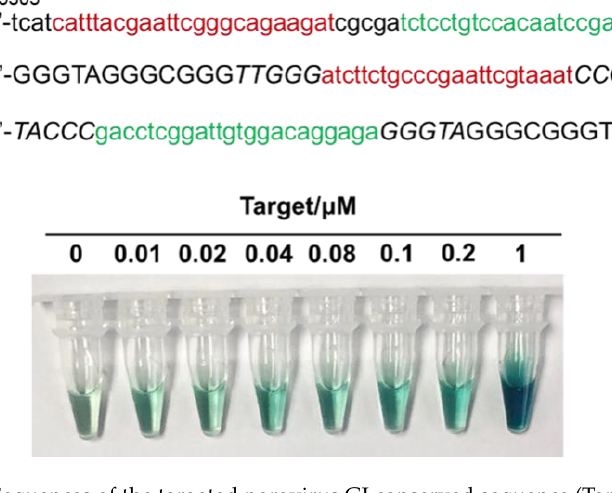
Figure 5. ( a ) Colorimetric observation and ( b ) UV absorbance of 0 – 1 μ M T-DL5 in the presence of 1 μ M P1-5 and 1 μ M P2-5 in colorimetric buffer. The inner panel in ( b ) illustrates the linear fitting of UV absorbance at 417 nm with 0 – 0.2 μ M T-DL5.